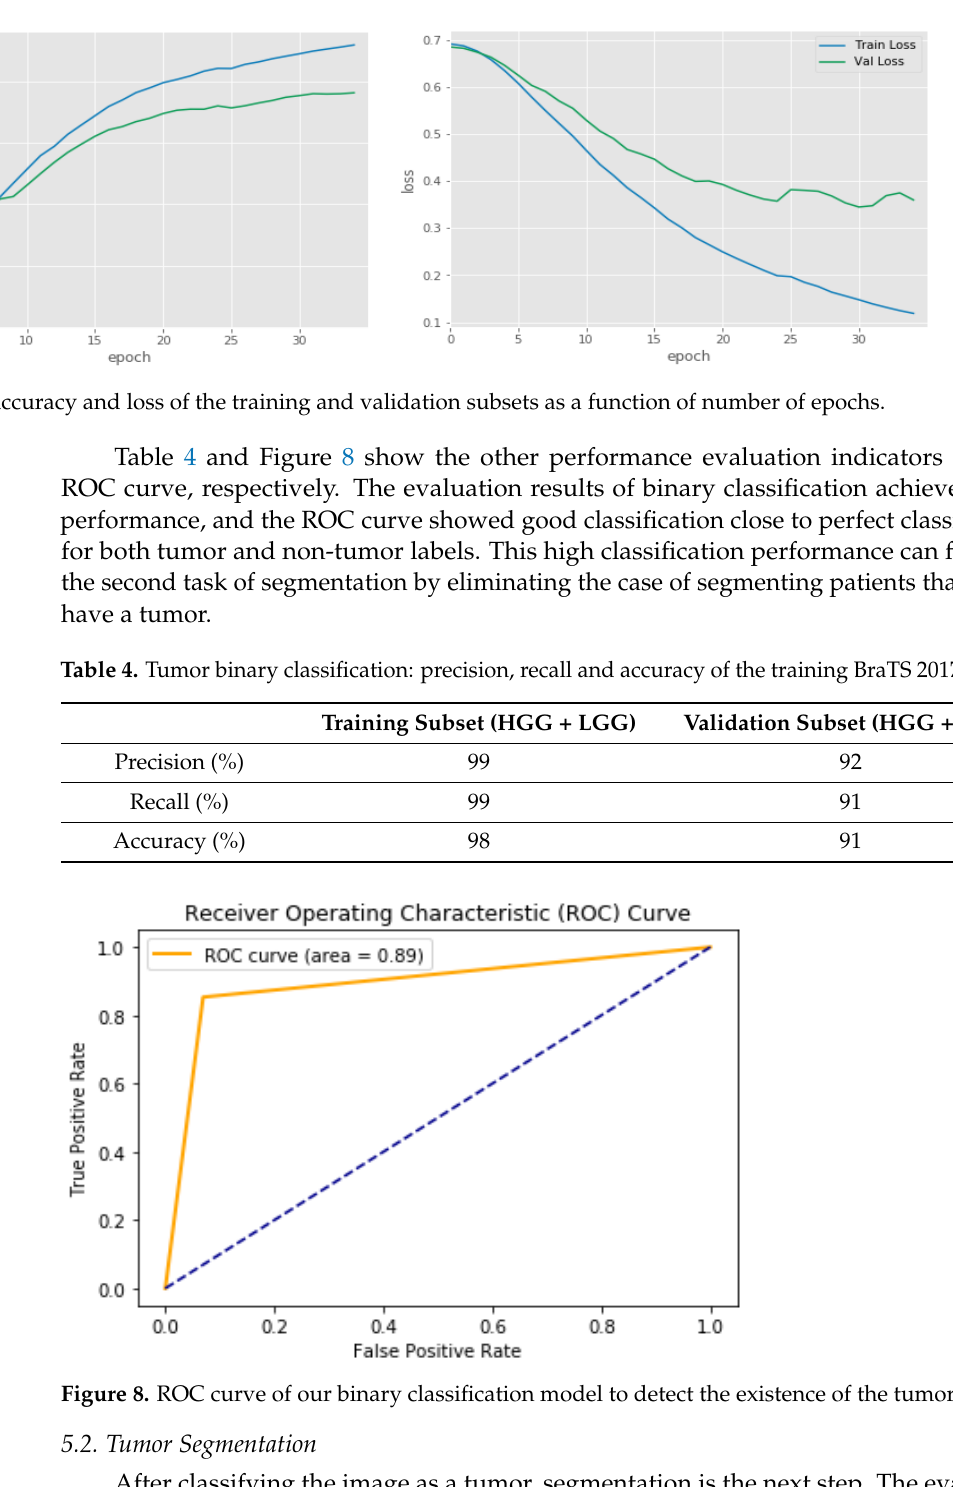
Figure 8. ROC curve of our binary classification model to detect the existence of the tumor.